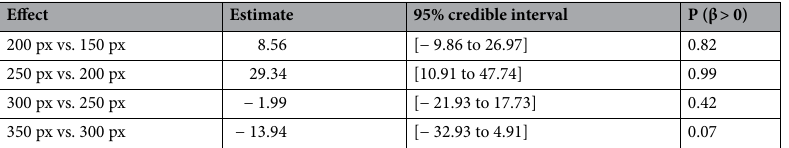
Table 1. Contrast estimates of the temporal error for consecutive spatial distances in Exp. 1 (temporal prediction). Positive values indicate that the response was longer in the consecutive level.